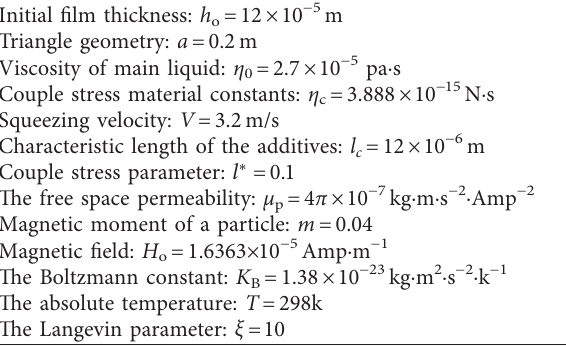
Table 1: Rheological parameters of